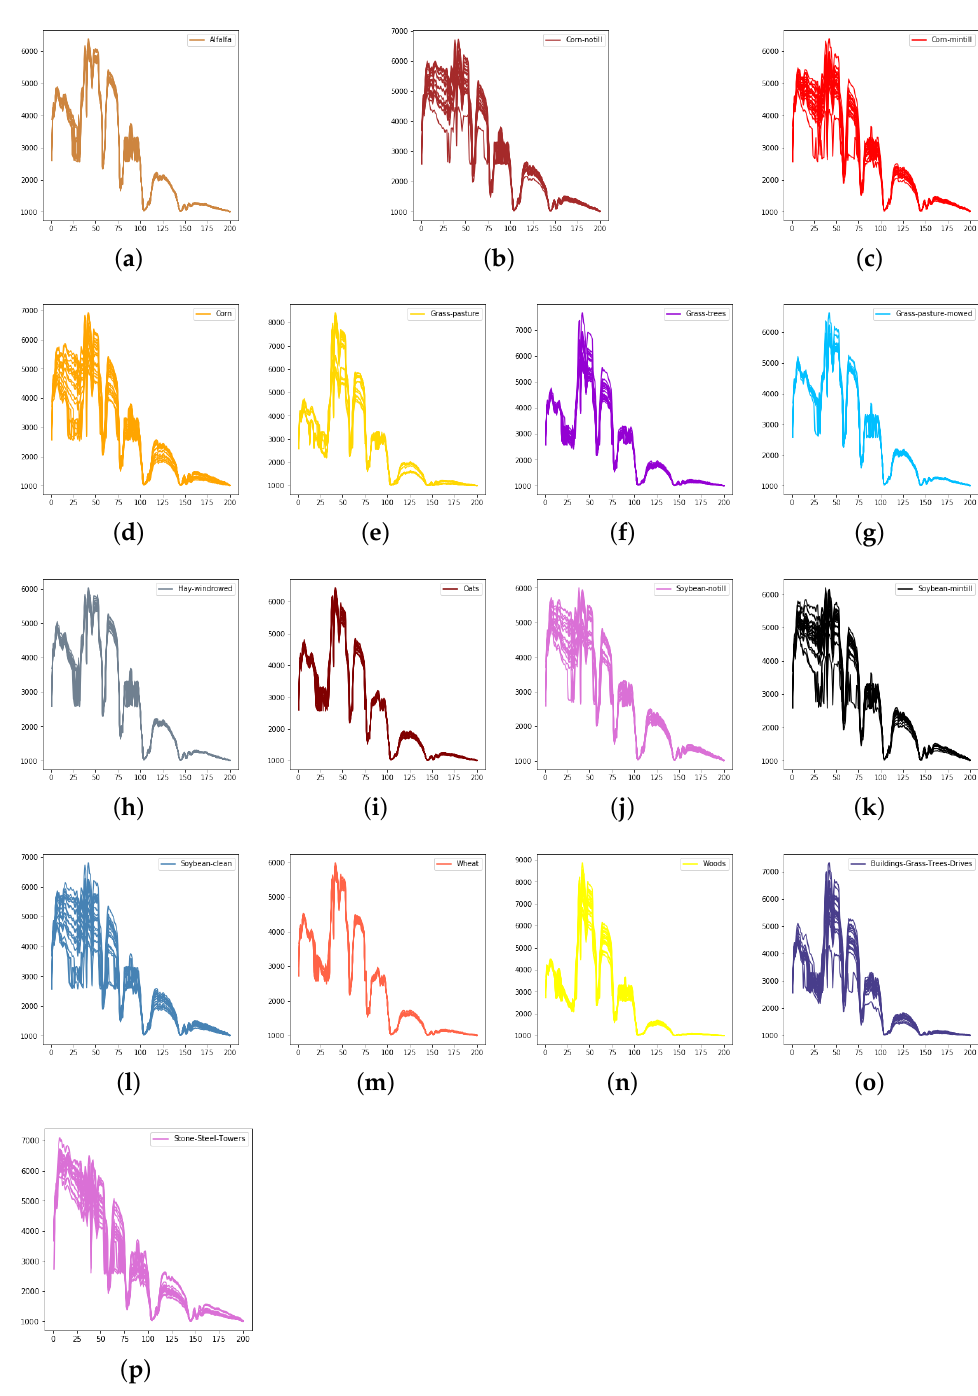
Figure 9. The spectral radiance of different pixels and the corresponding categories in Indian Pines. ( a ) Alfalfa. ( b ) Corn-notill. ( c ) Corn-mintill. ( d ) Corn. ( e ) Grass-pasture. ( f ) Grass-trees. ( g ) Grass-pasture-mowed. ( h ) Hay-windrowed. ( i ) Oats. ( j ) Soybean-notill. ( k ) Soybean-mintill. ( l ) Soybean-clean. ( m ) Wheat. ( n ) Woods. ( o ) Buildings-Grass-Trees-Drives. ( p )